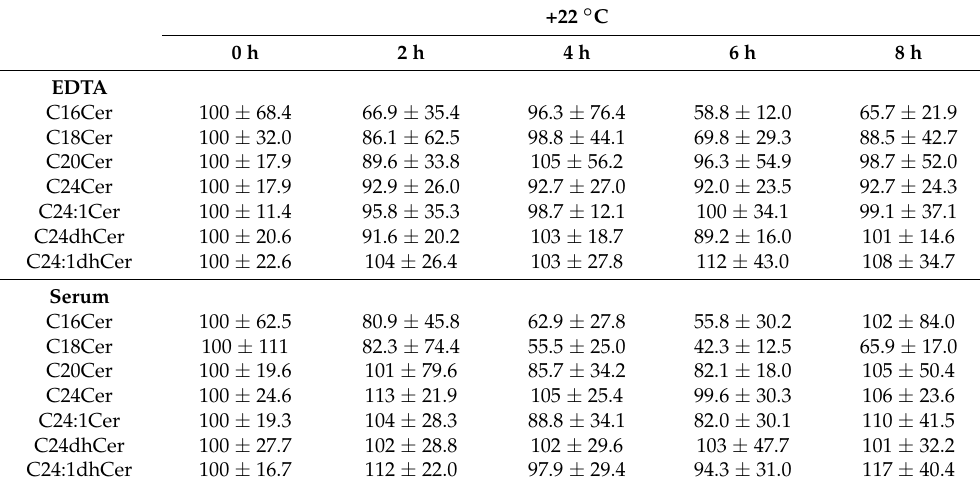
Figure 1. Time-dependent effect on relative sphingosine 1-phosphate ( A ) and sphinganine 1-phosphate ( B ) levels in human blood samples. Whole blood samples (EDTA as anticoagulant or serum) were incubated at +22 °C for the indicated times. Thereafter, plasma and serum were isolated as described in the Material and Methods section. Plasma and serum samples without storage time served as the respective controls (0 h; 100%). After final preparation, all samples were stored at − 80 °C until LC-MS/MS analysis. Data are shown as the mean (in %) ± SD ( n = 4). * p < 0.05, *** p < 0.001. Table 2. Time-dependent effect on relative sphingolipid levels in human blood